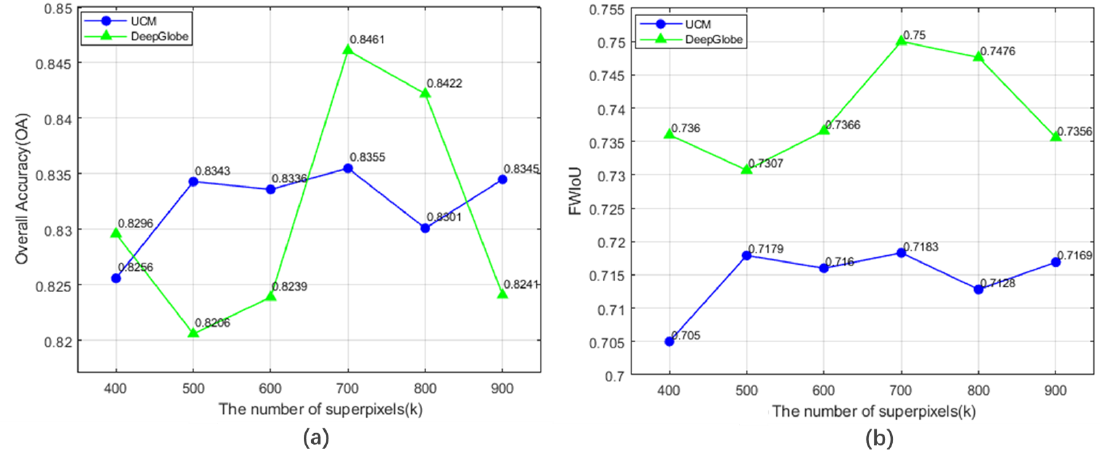
Figure 7. Sensitivity analysis of the number of superpixels 𝑘 tested on the validation dataset. ( a ) and ( b ) present the change trend of OA and FWIoU with 𝑘 , respectively.